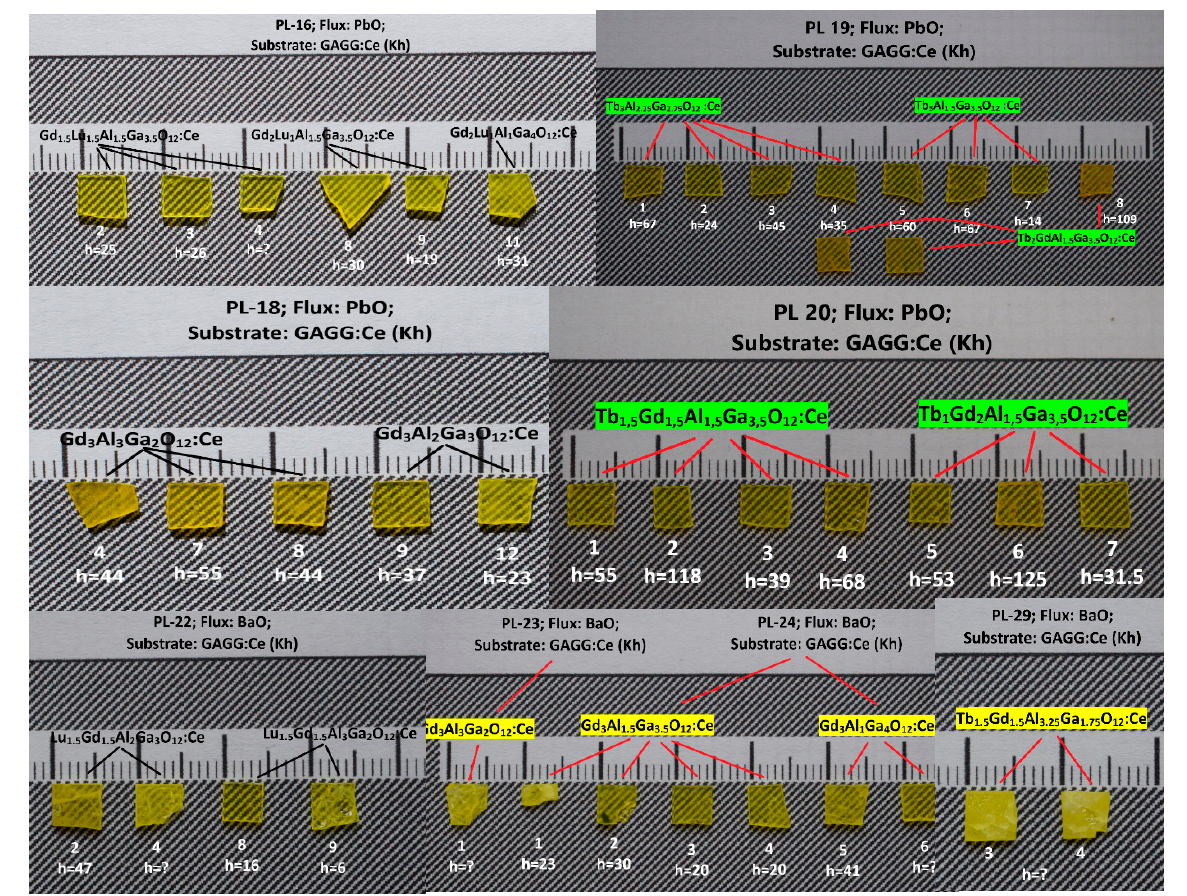
Figure 1. Multicomponent garnet composite scintillators fabricated in this work and their thicknesses in μ m.